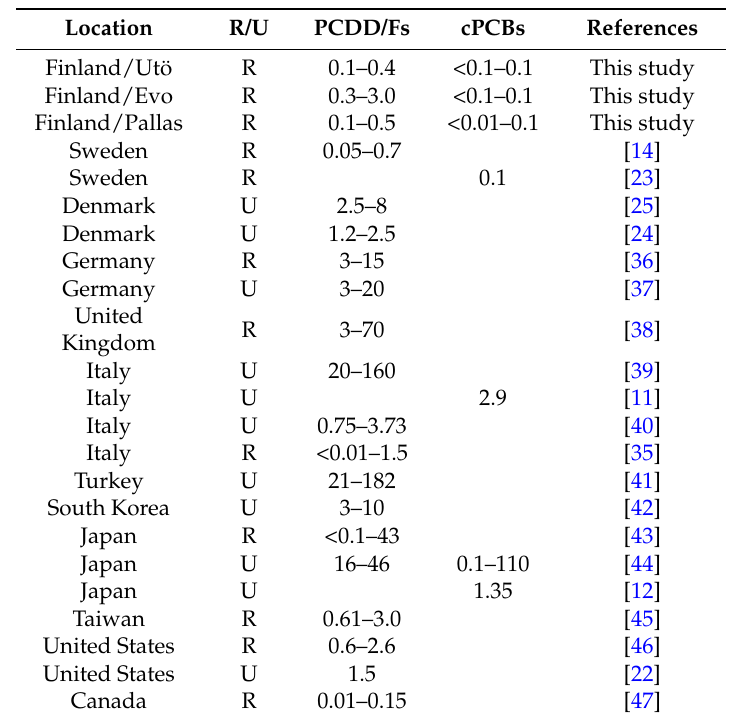
Table 2. The deposition of PCDD/Fs and cPCBs calculated as WHO-TEQ [34] (pg/m 2 /day) in some countries, rural (R)/urban (U) (Wallenhorst, Bakogly, Vikelsoe, and Chi I-TEQ).